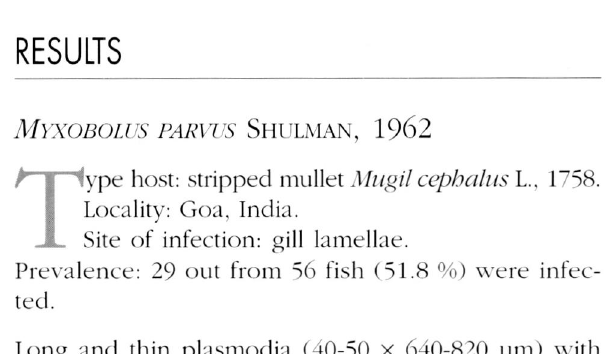
Long and thin plasmodia (40-50 x 640-820 um) with pointed tips were observed in a longitudinal position along the secondary lamellae, appearing as thin,